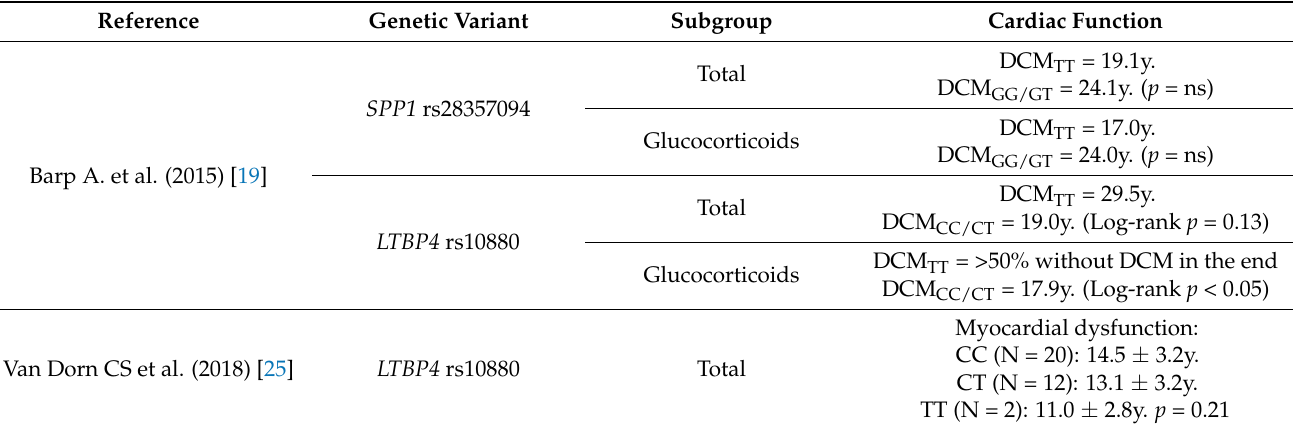
Table 4. Studies including cardiac function as an